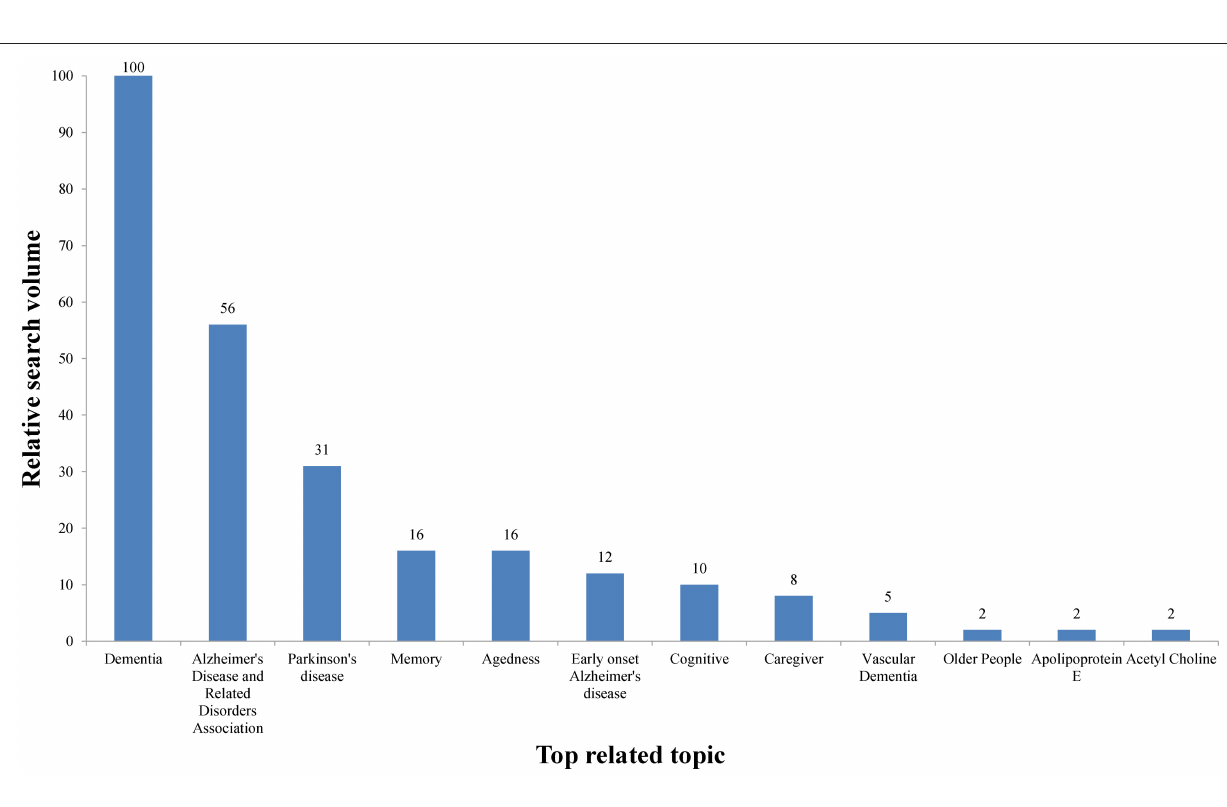
FIGURE 3 | The histogram of the top related